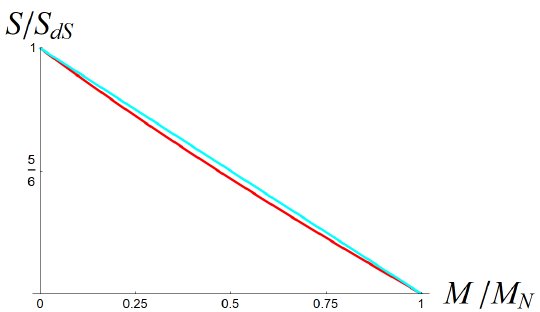
= S + S in units of the de Sitter entropy SdS b c , where we have set d = 4. The red curve N